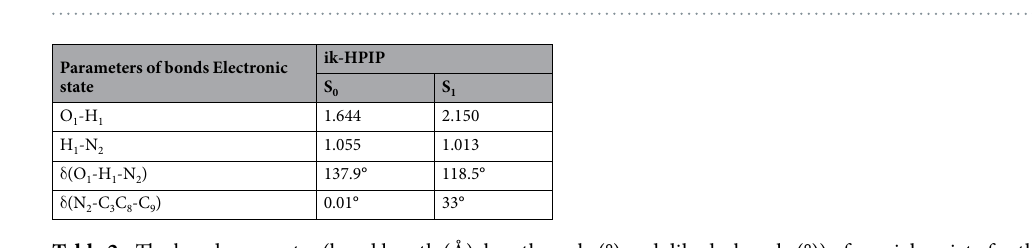
Table 2. The bond parameter (bond length (Å), length angle (°) and dihedral angle (°)) of crucial moiety for the ik-HPIP in the S 0 and S 1 state.